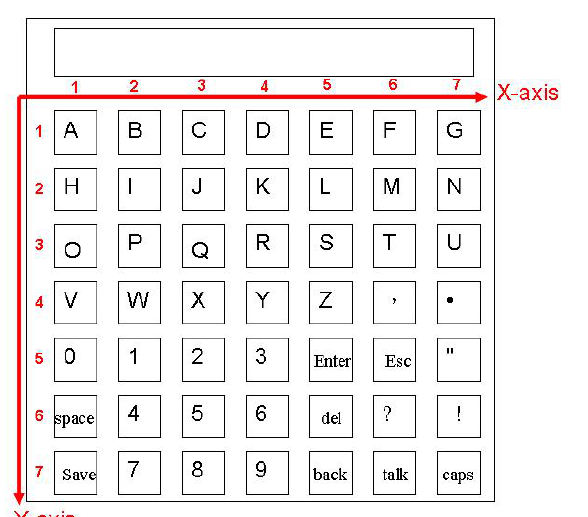
Figure 6. English virtual